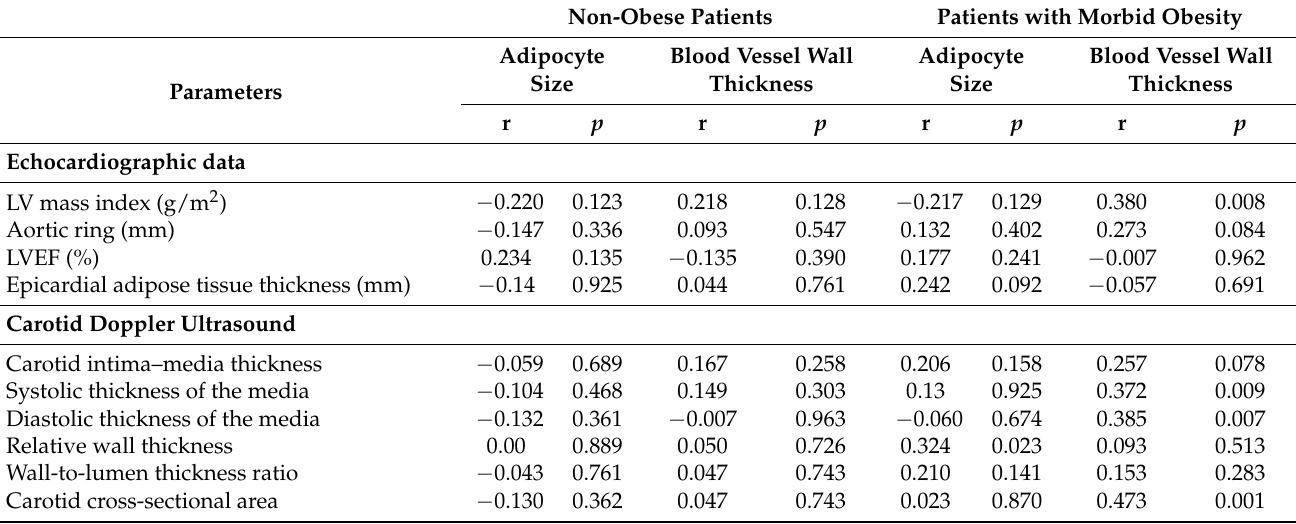
Table 3. Correlations between adipocyte size and blood vessel wall thickness with imaging